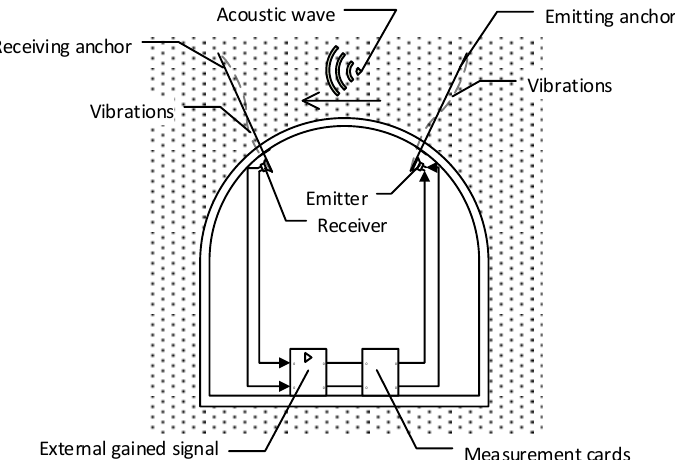
Figure 1. Example of application of SAS system in a drilled gallery with circular vault-system with separated transmitting and receiving